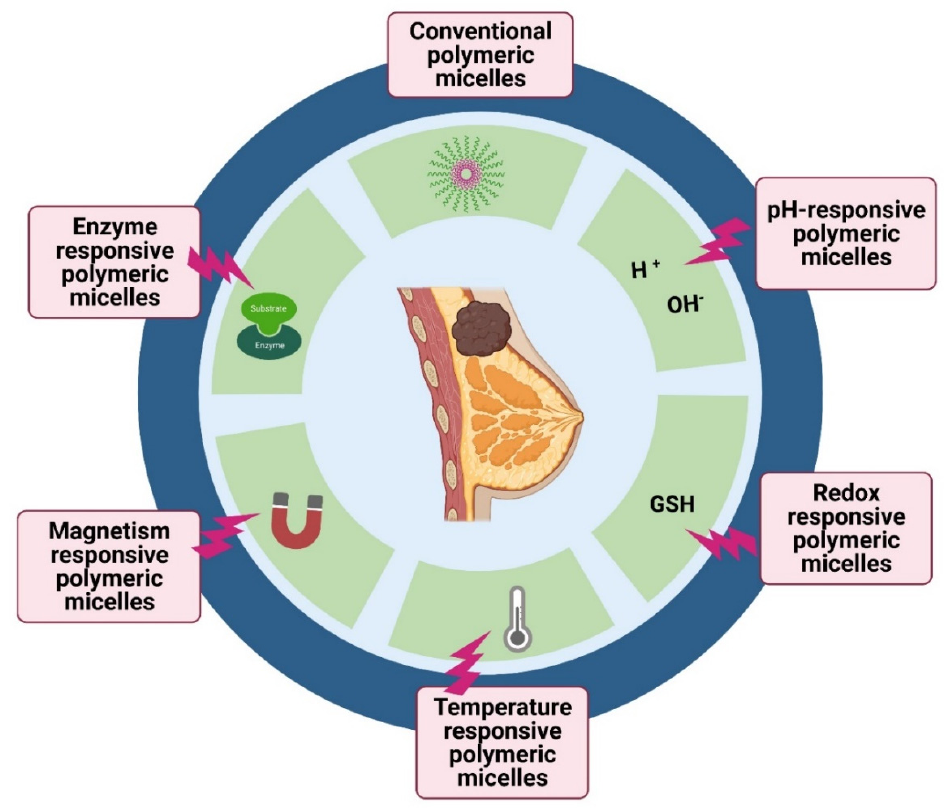
Figure 6. Various strategies in micellar tumor targeting to deliver therapeutic cargoes.